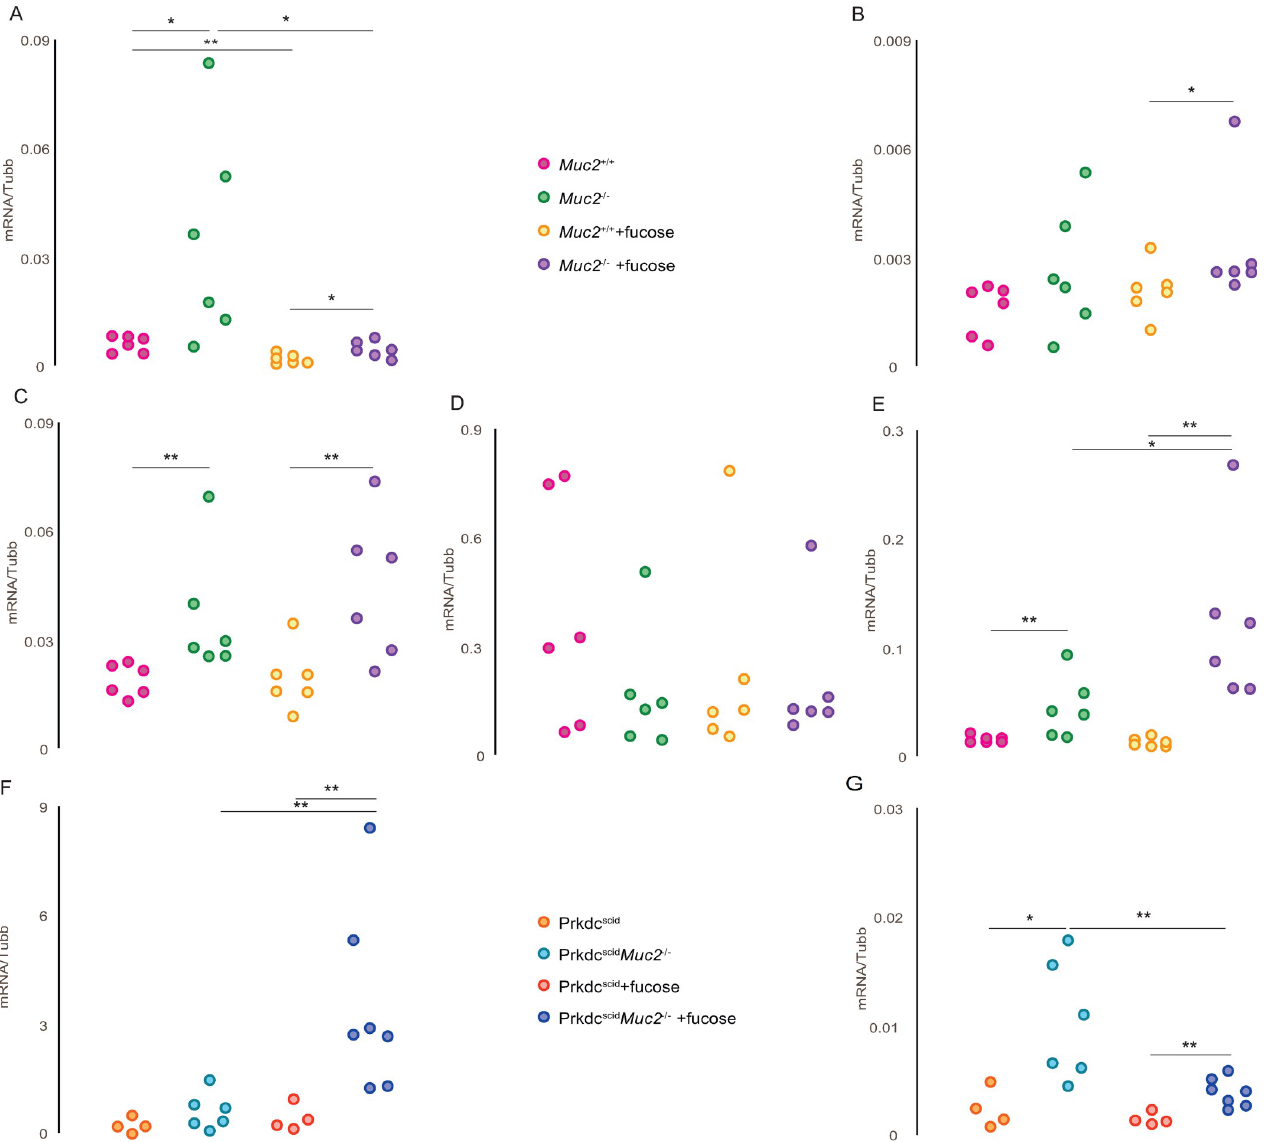
Fig 4. Expression of macrophage and T-cell activation marker genes in the distal colon. ( � = p < 0.05, �� = p < 0.01, Mann-Whitney u-test). (A) Nos2 gene expression in Muc2 −/− and Muc2 +/+ mice with and without L-fucose treatment. (B) Arg1 gene expression in Muc2 −/− and Muc2 +/+ mice with and without L- fucose treatment. (C) Tbx21 gene expression in Muc2 −/− and Muc2 +/+ mice with and without L-fucose treatment. (D) Rorc gene expression in Muc2 −/− and Muc2 +/+ mice with and without L-fucose treatment. (E) Foxp3 gene expression in Muc2 −/− and Muc2 +/+ mice with and without L-fucose treatment. (F) Nos2 gene expression in Prkdc SCID Muc2 −/− and Prkdc SCID mice with and without L-fucose treatment. (G) Arg1 gene expression in Prkdc SCID Muc2 −/− and Prkdc SCID mice with and without L-fucose